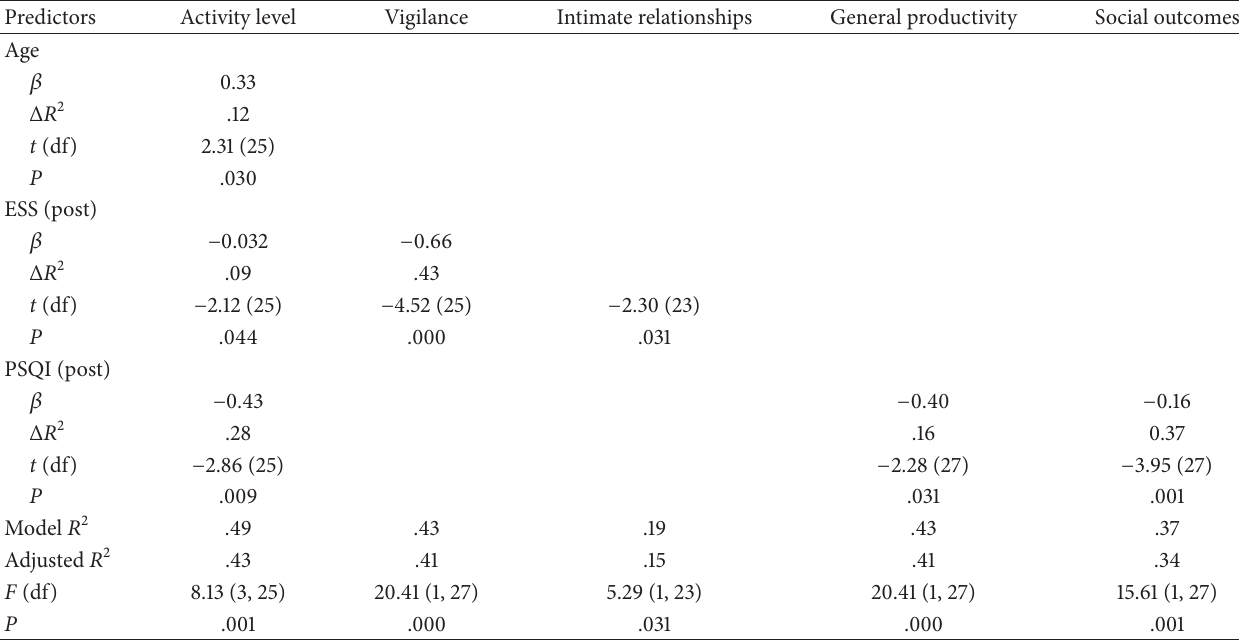
Table 5: Prediction of Functional Outcomes of Sleep Questionnaire subscales in participants with OSA treated with CPAP using stepwise regression. Predictors Activity level Vigilance Intimate relationships General productivity Social outcomes